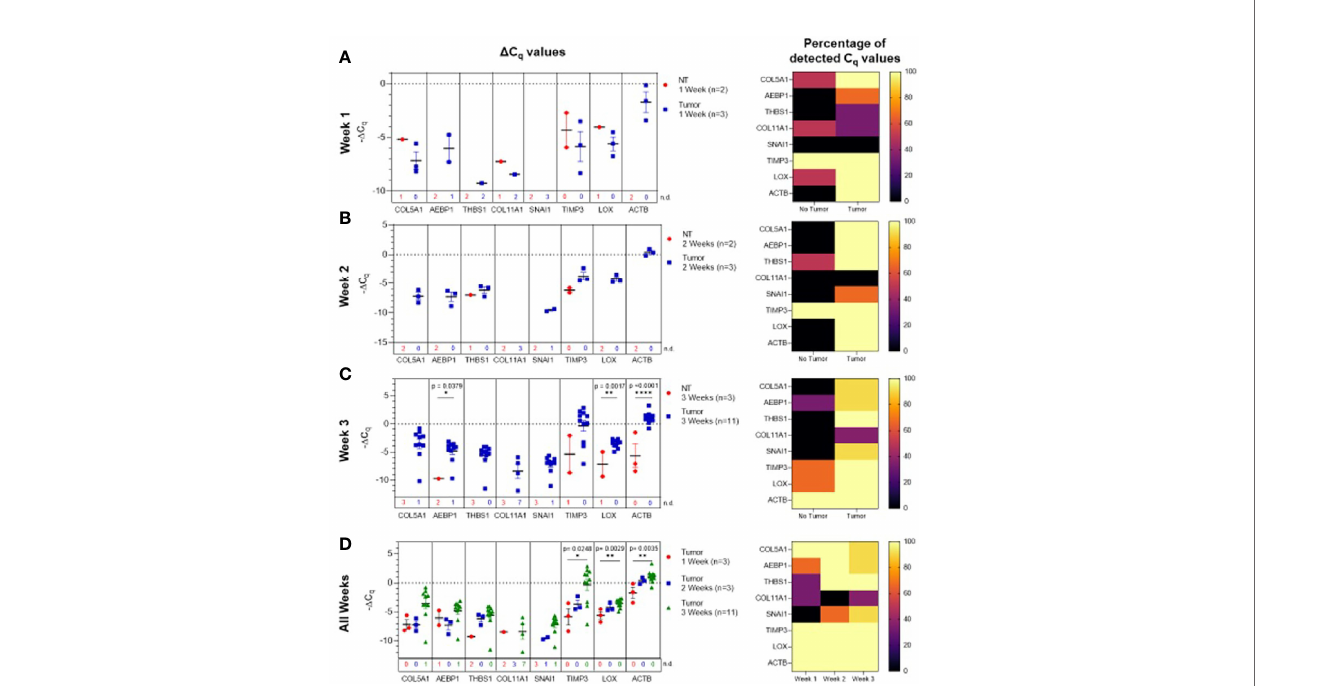
FIGURE 5 | Ascites-derived sEV gene expression in a mouse model of ovarian cancer. Scatter plots of D C q values and heat maps showing the percentage of detected C q values at (A) Week 1, tumor- (blue, n=3) and non-tumor-bearing samples (red, n=2); (B) Week 2, tumor- (blue, n=3) and non-tumor-bearing samples (red, n=2); (C) Week 3, tumor- (blue, n=11) and non-tumor-bearing samples (red, n=3); (D) over Week 1 (red, n=3), Week 2 (blue, n=3), and Week 3 (green, n=11) of tumor development. p values for unpaired two-tailed t-test are labeled in the graphs. The number of non-detected (n.d.) C q values in each experimental group are listed underneath the corresponding scatter plots. Heat maps indicate the absence/presence of the target gene (percentage of detected C q values) in each experimental group. *p<0.05, **p<0.01, ***p<0.001,